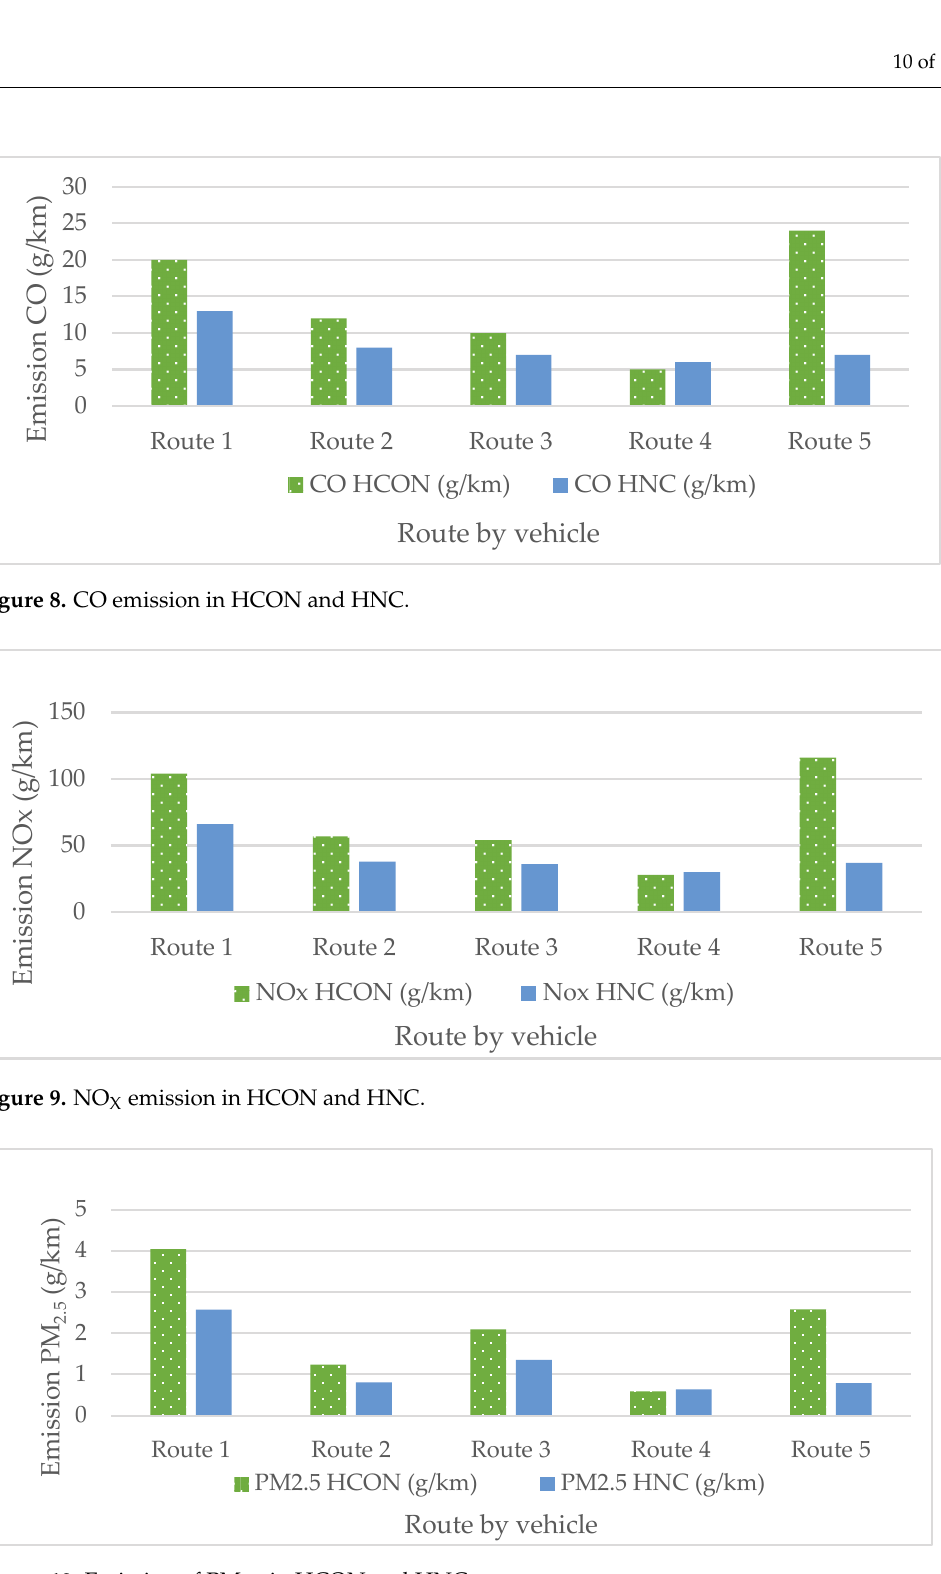
Figure 7. CO 2 emission in HCON and HNC.